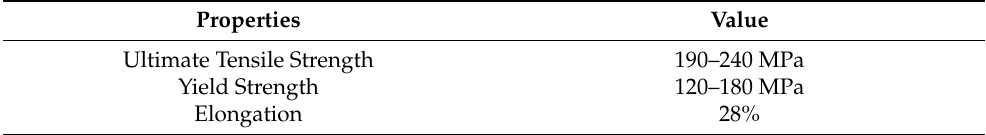
Table 1. Mechanical properties of the LITECOR ® panel